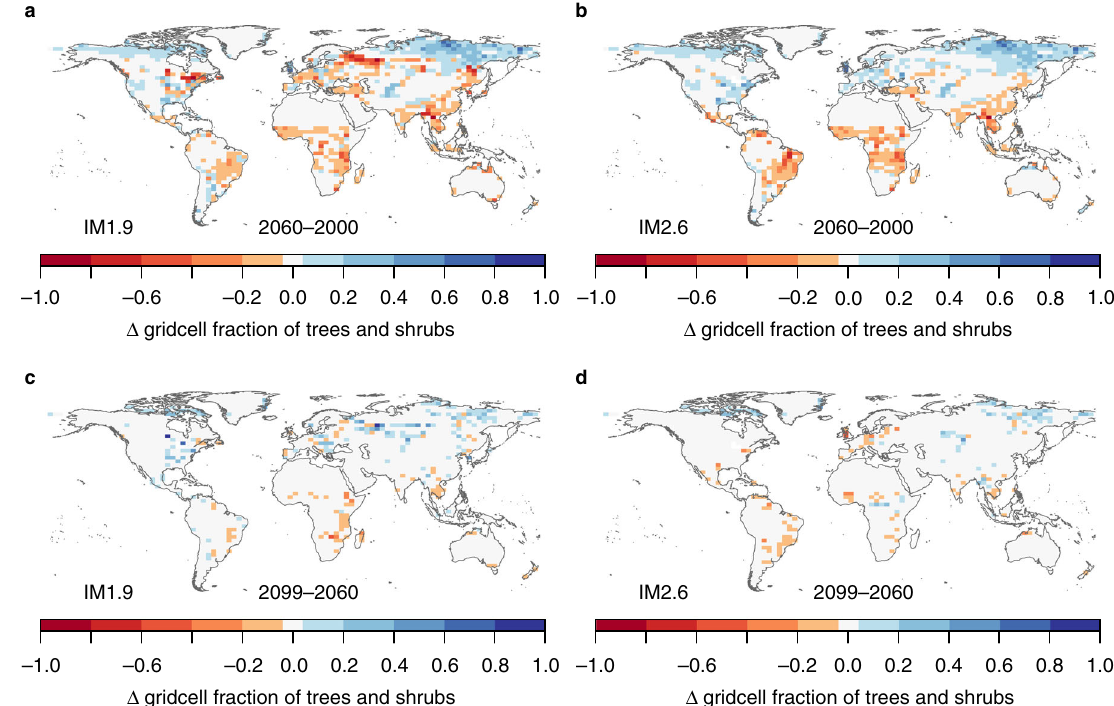
Fig. 4 Changes in tree and shrub coverage simulated by the land surface model JULES (units = fraction of grid cell). The changes are from 2000 to 2060 ( a , b ) and from 2060 to 2099 ( c , d ) for the two land-use scenarios with the 1.5 °C climate change